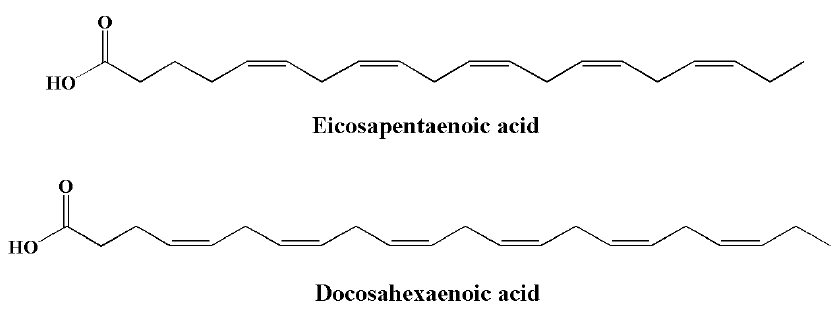
Figure 7. Chemical structures of marine-based omega-3 fatty acids with anti-inflammatory po-